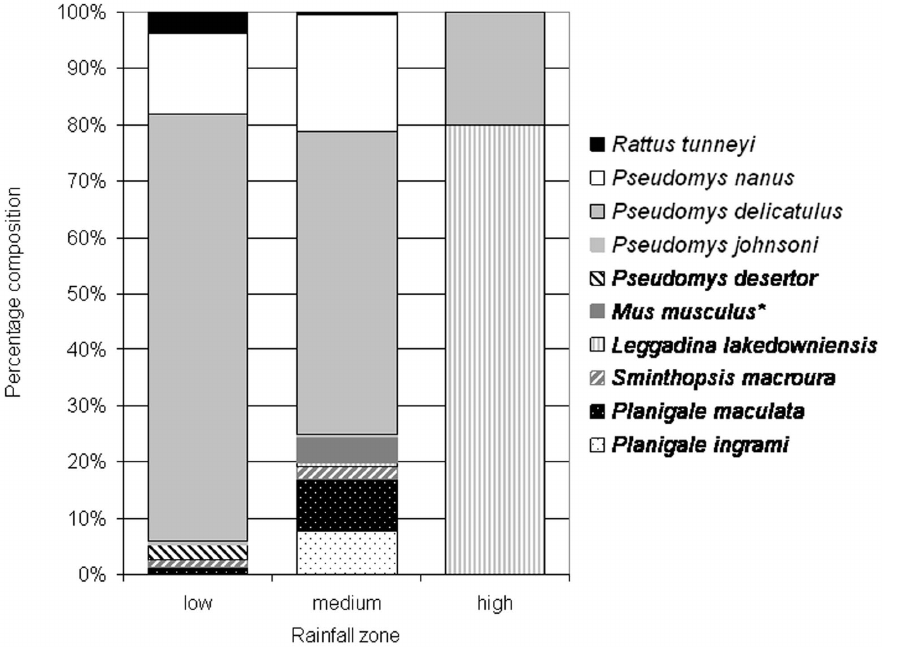
Figure 5. Mammal species data from pitfall traps set in the Kimberley, northern Australia, where data could be separated from other trapping information. Trapping results are shown for different percentages of total captures. Pitfall trap data were provided by the Australian Defence Force, Thomson, Partridge, Graham, Radford and Everitt.